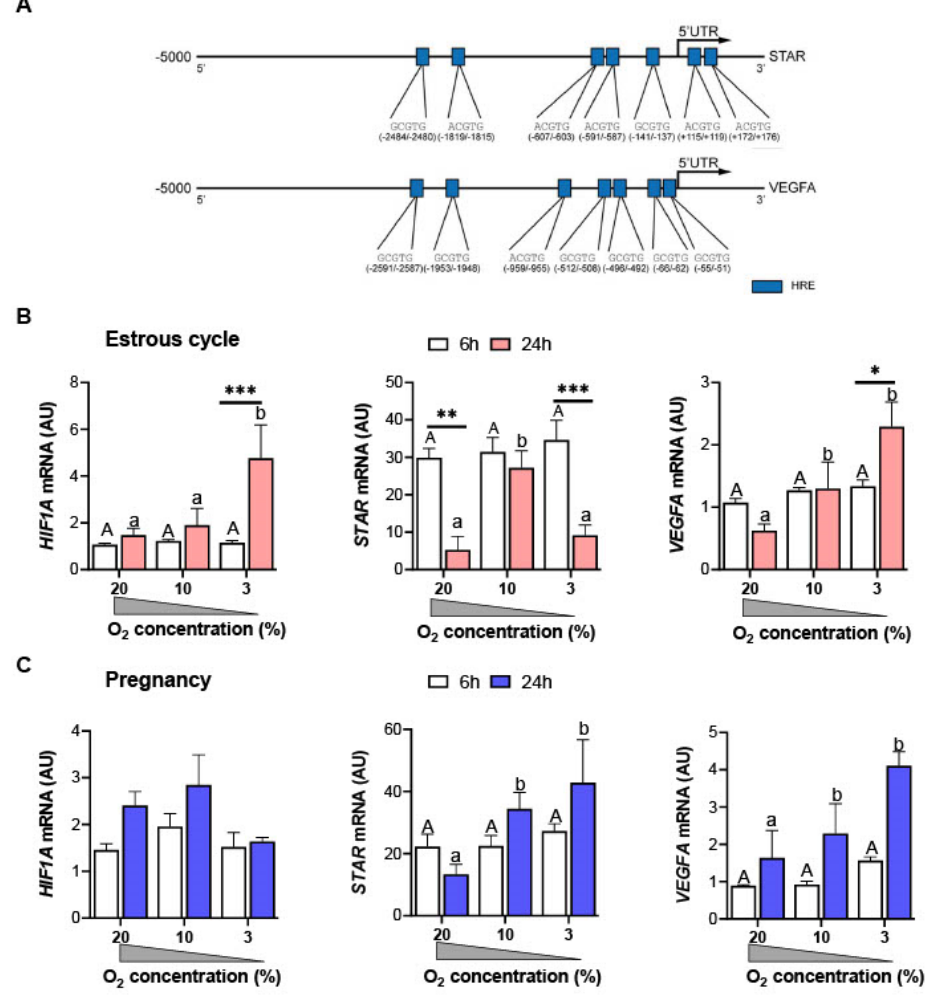
Figure 2. Hypoxia response elements (HREs) [(A/G)CGTG] identified within the DNA sequences of a promoter (5000 bp upstream) of porcine STAR and VEGFA ( A ). The expression of mRNA in the luteal tissue slices of cyclic (day 13 of the estrous cycle; ( B )) and/or early pregnant gilts (day 13 of pregnancy; ( C )) after incubation in the different O 2 concentrations (20, 10, and 3% O 2 ) for 6 and 24 h. Data were normalized to GAPDH (AU) and are presented as mean ± SEM ( n = 5–7 per reproductive status). The analysis was performed by using a two-way ANOVA with Bonferroni post hoc test. Capital and small letters denote significant differences between the different concentrations of O 2 across 6 and 24 h incubations, respectively. Significant changes between the time of incubation are indicated with asterisks (* p < 0.05, ** p < 0.01, and *** p < 0.001). AU, arbitrary units.